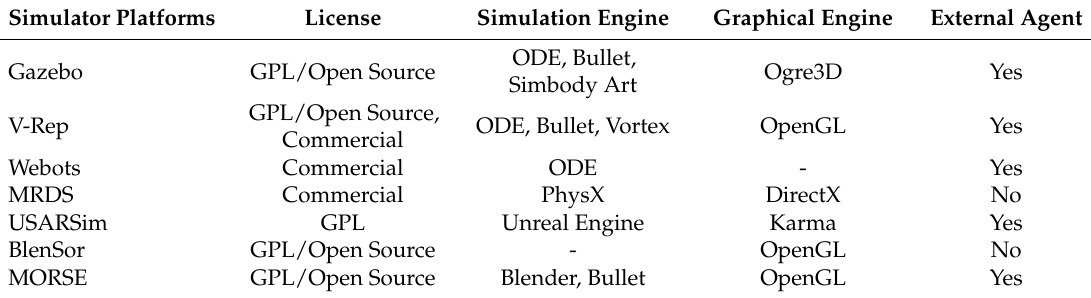
Table 4. Summary of the main features of robotic simulator platforms for